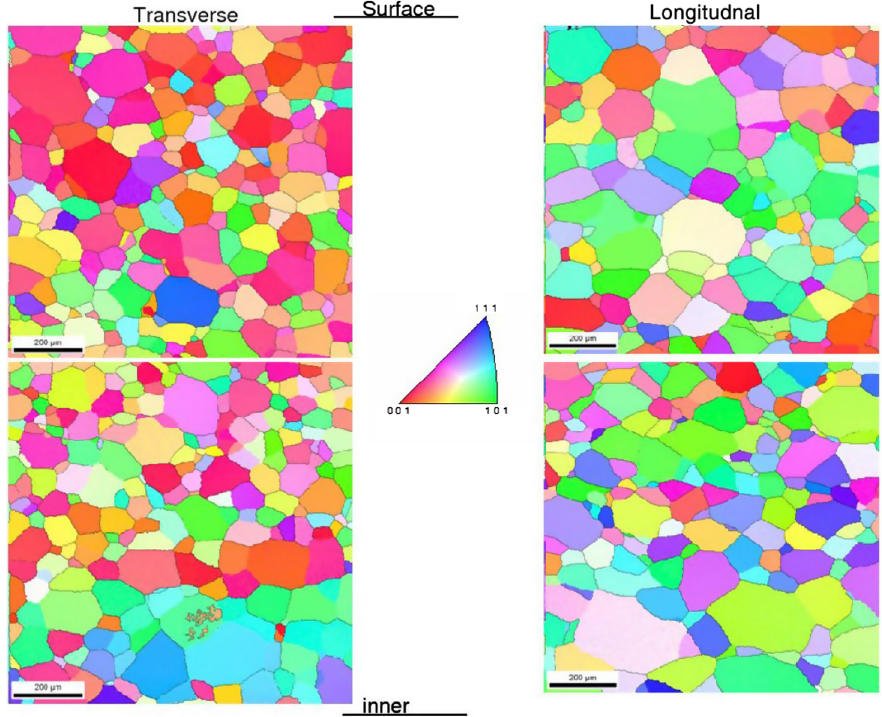
FIG. 26. Orientation Imaging microscope figures of the Nb tube produced by combination of spinning and flow forming.